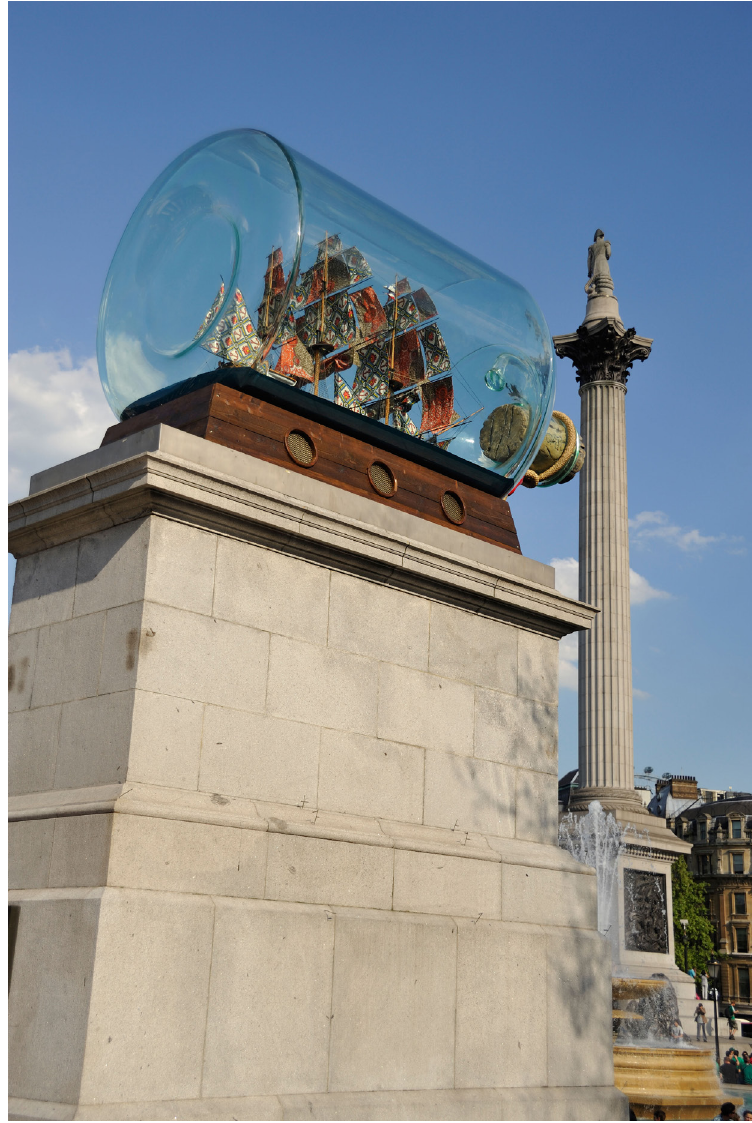
Figure 2: Yinka Shonibare, Nelson’s Ship in a Bottle, London’s Trafalgar Square. Photograph by Philip Sayer/ Alamy Stock Photo. Sculpture © Yinka Shonibare MBE. All Rights Reserved, DACS / ARS, NY